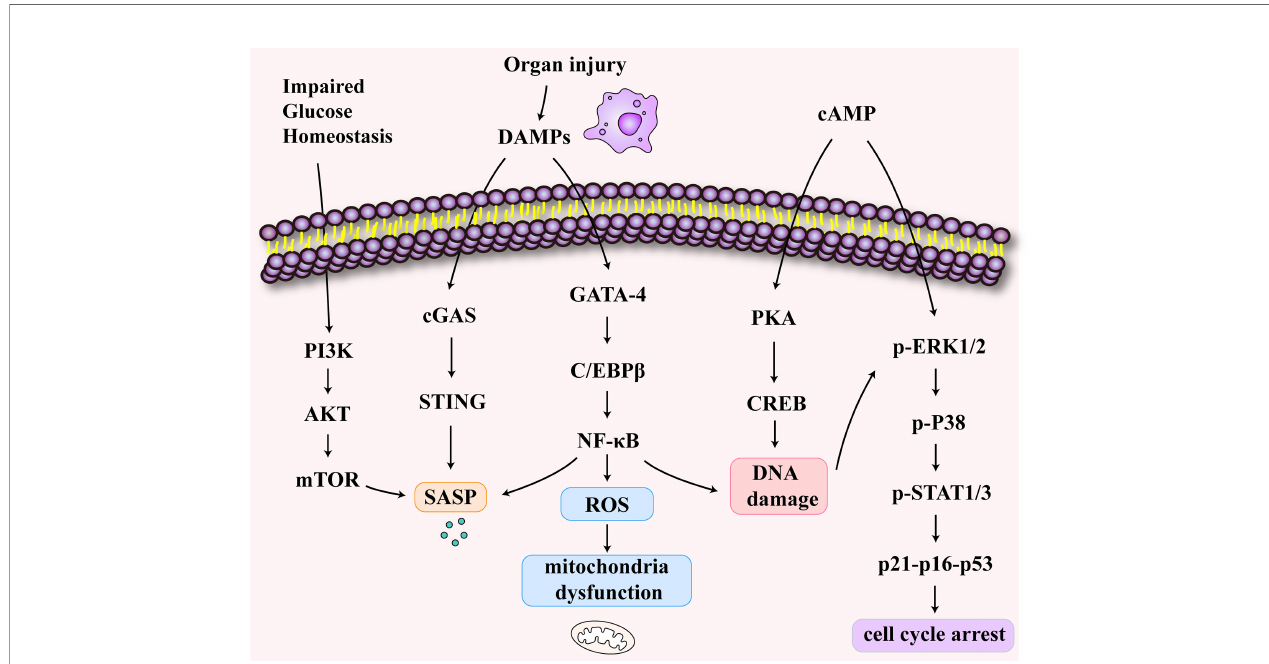
FIGURE 3 | The signaling pathways of T cell senescence following sepsis-associated organ injury. The disruption of glucose metabolism activates the PI3K-AkT- mTOR signaling pathways in senescent T cells. The increase of cyclic adenosine monophosphate (cAMP) activates cAMP-PKA-CREB pathway, ERK1/2 and p38 pathways. These pathways may induce DNA damage and cell cycle arrest. The release of damage-associated molecular patterns (DAMPs) activates cGAS-STING pathway and NF k B pathway which may be related to SASP secretion and mitochondrial